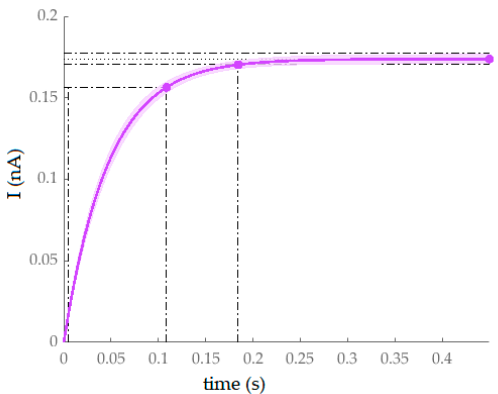
Figure 6. Unit step response of the system G ( s ) with confidence region.